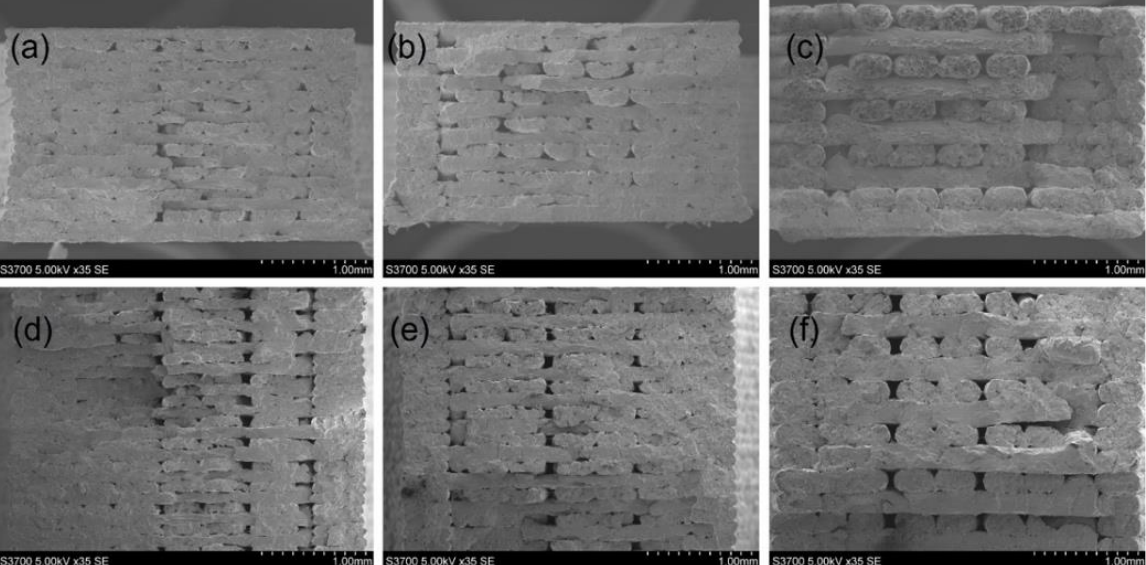
Figure 5. SEM images (35×) of the structure of the printed [0, 90] composite samples with different thickness: 2 mm: ( a ) SFRN_0.1, ( b ) SFRN_0.125, ( c ) SFRN_0.2; 4 mm: ( d ) SFRN_0.1, ( e ) SFRN_0.125, ( f ) SFRN_0.2.